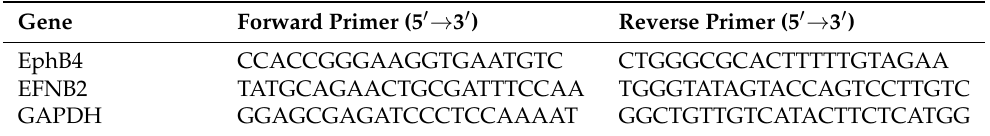
Table 1. RT-qPCR primers used in this study.